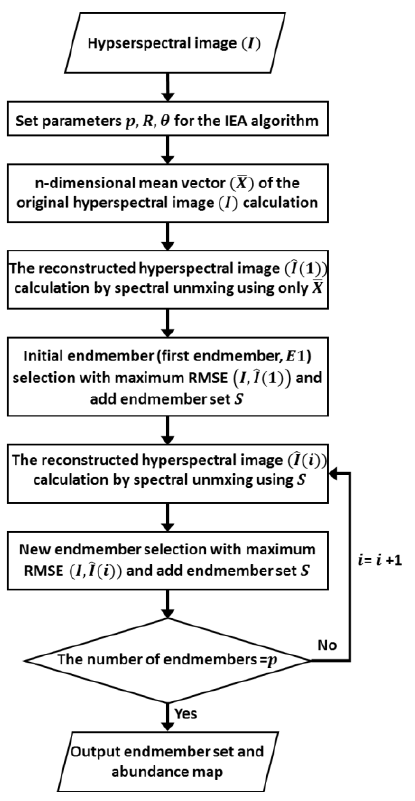
Figure 1. Logical flow of the IEA